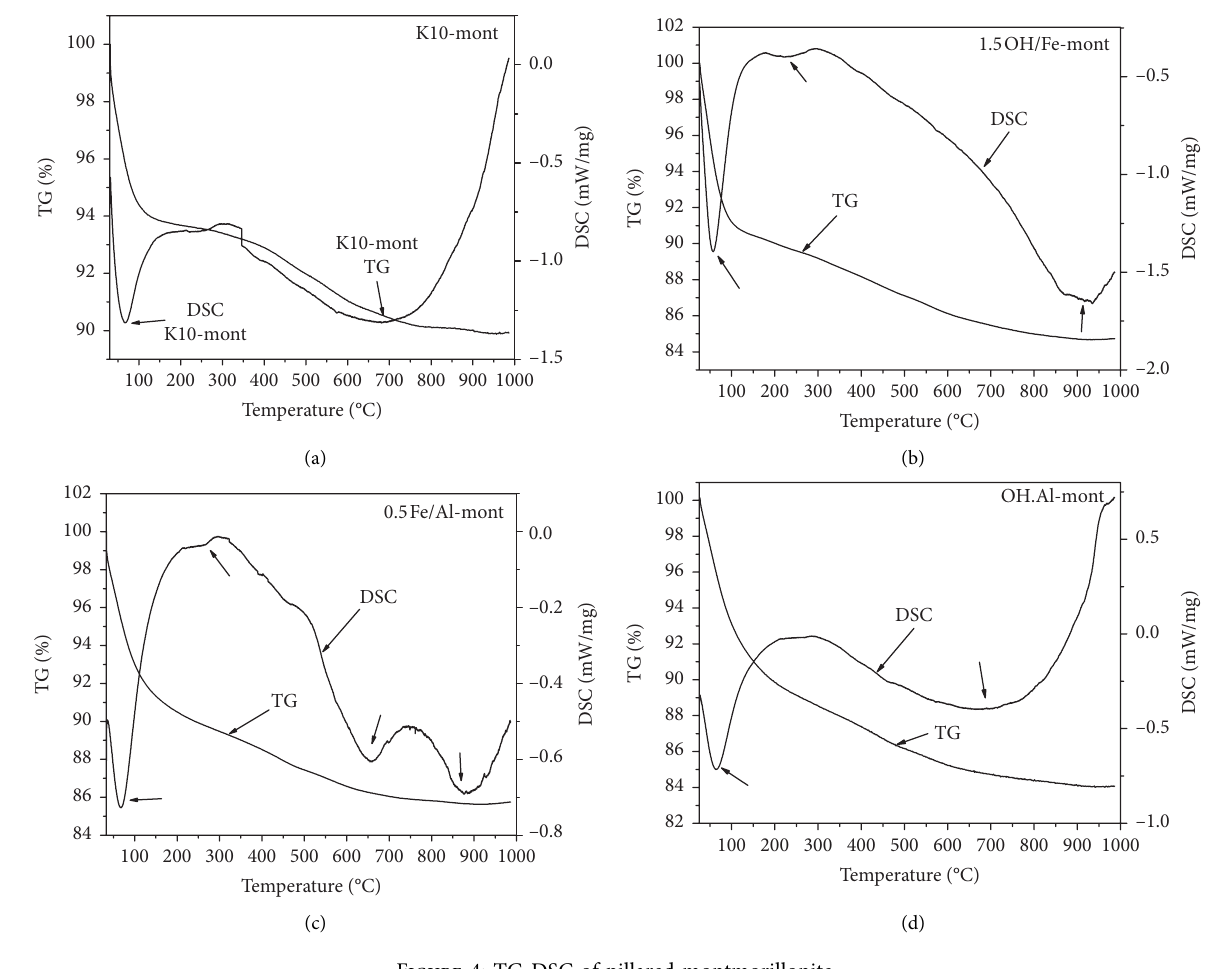
Figure 4: TG-DSC of pillared